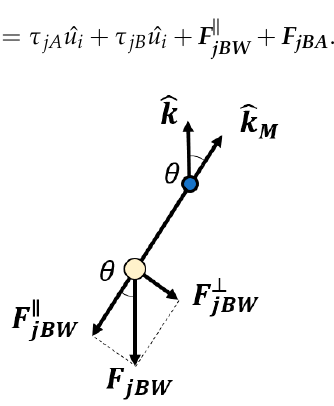
Figure 3. Weight force acting on the gripper. It is projected in parallel to the cable, imposing the tension 𝜏 (cid:3011)(cid:3003) , and perpendicular to the cable, acting on the main body of the end